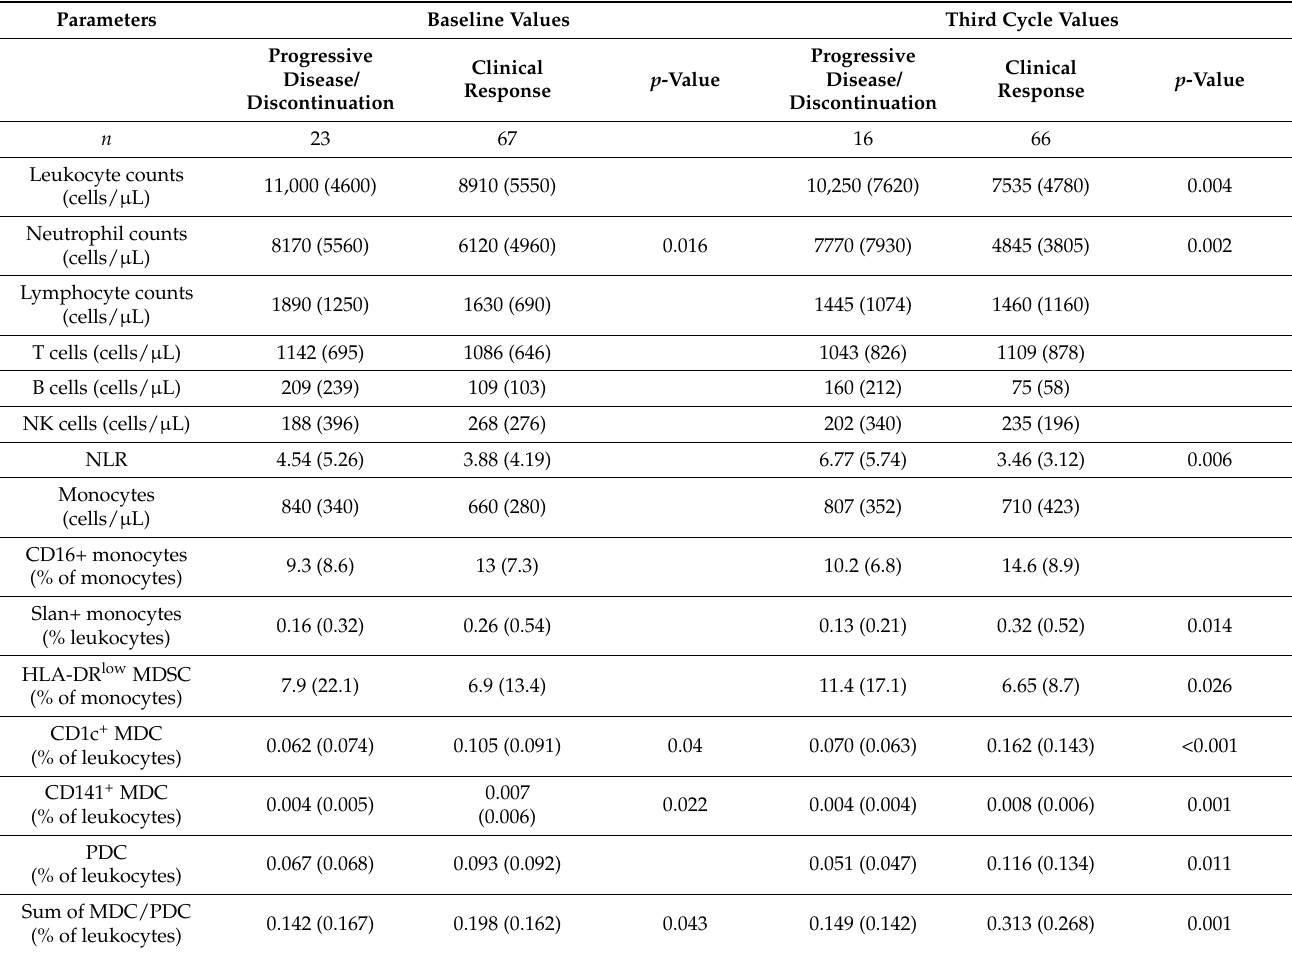
Table 2. Blood immune cell parameters at baseline and at third cycle of ICI/chemotherapy. The patients were grouped into progress/discontinuation and clinical response (stabilization of disease, or partial/complete remission). Median and interquartile range (IQR) are